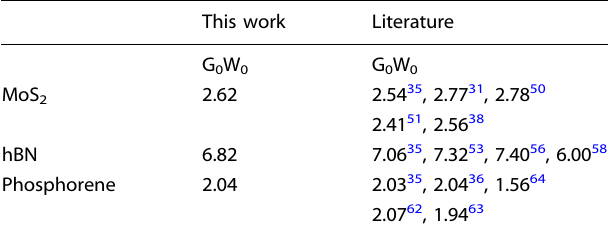
Table 1. Converged G 0 W 0 gaps of MoS 2 , hBN, and phosphorene as obtained within our work and found in the literature. This